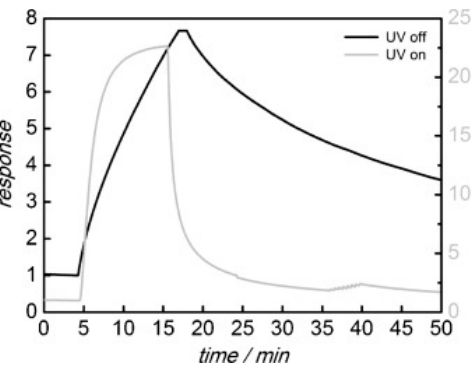
Figure 40. Dynamic response and recovery curve of mesoporous In 2 O 3 to 5 ppm NO 2 in dry synthetic air at 50 °C with and without UV illumination. Reproduced with permission from [68].